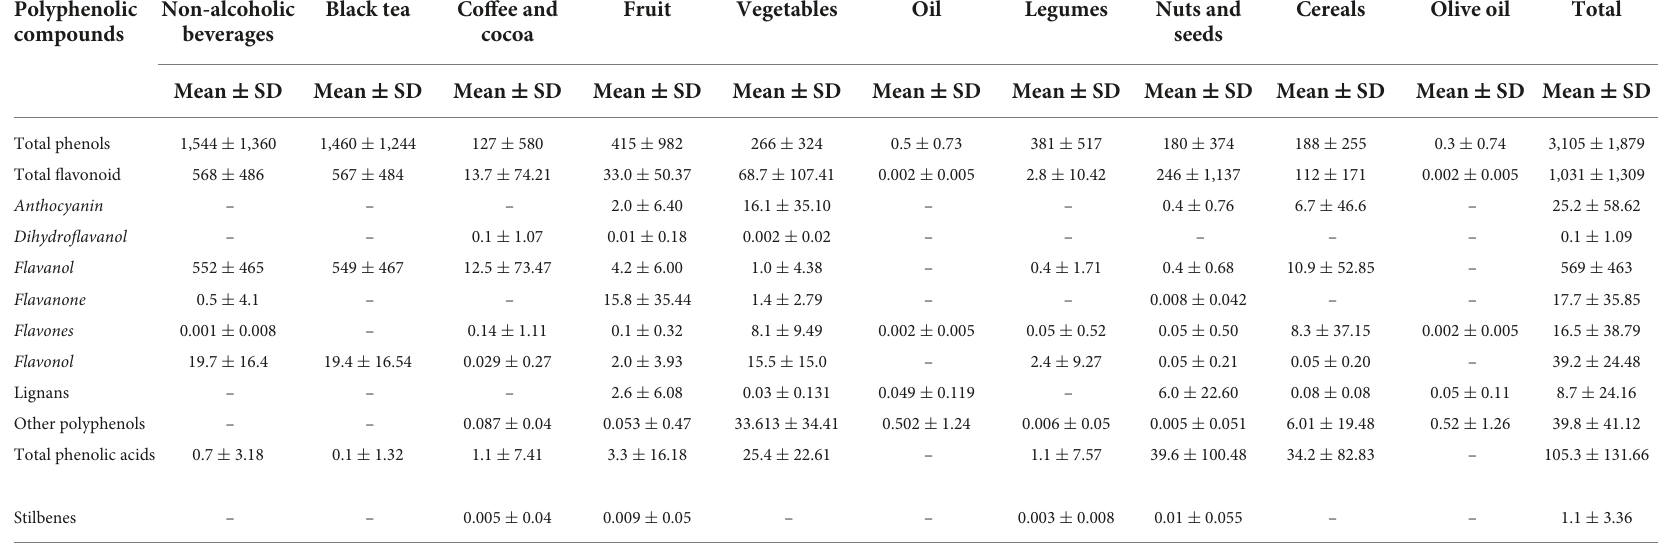
TABLE 3 Participants’ intake of phenolic compounds (mg/day) according to the food